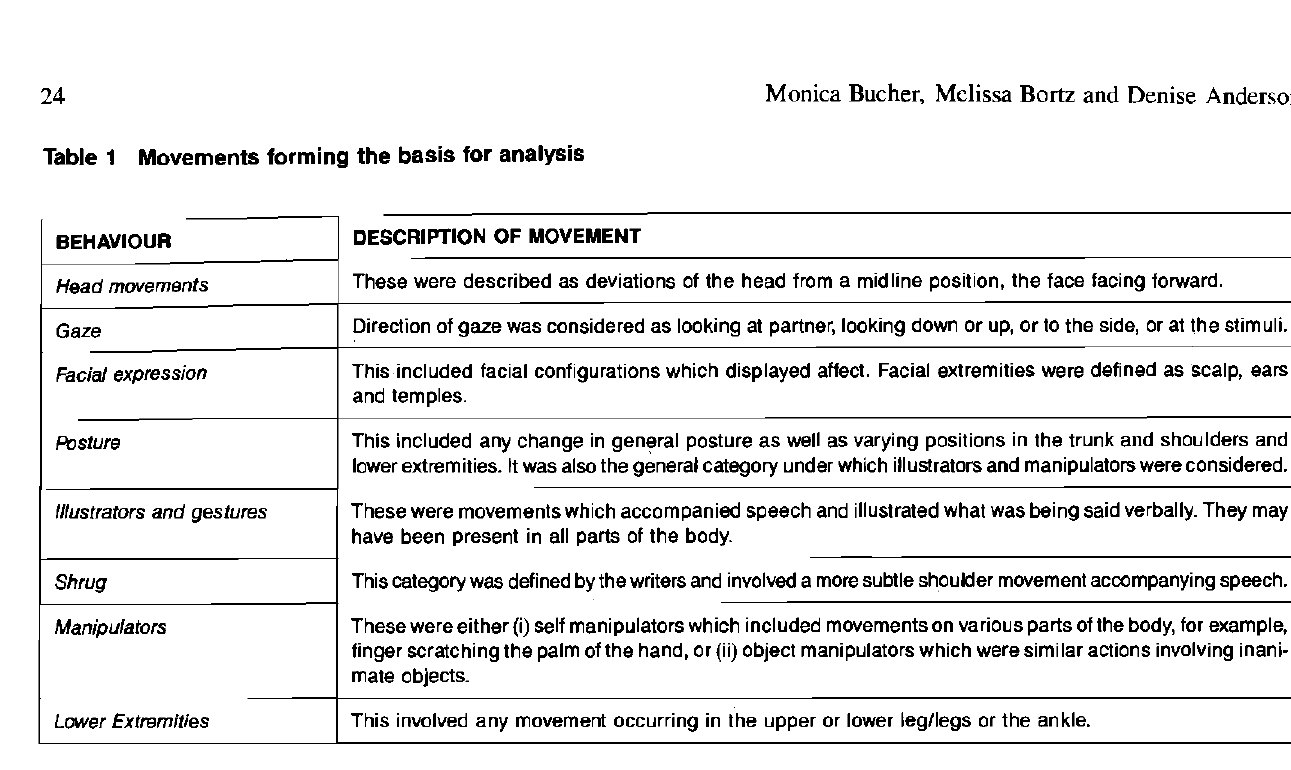
Table 1 Movements forming the basis for analysis